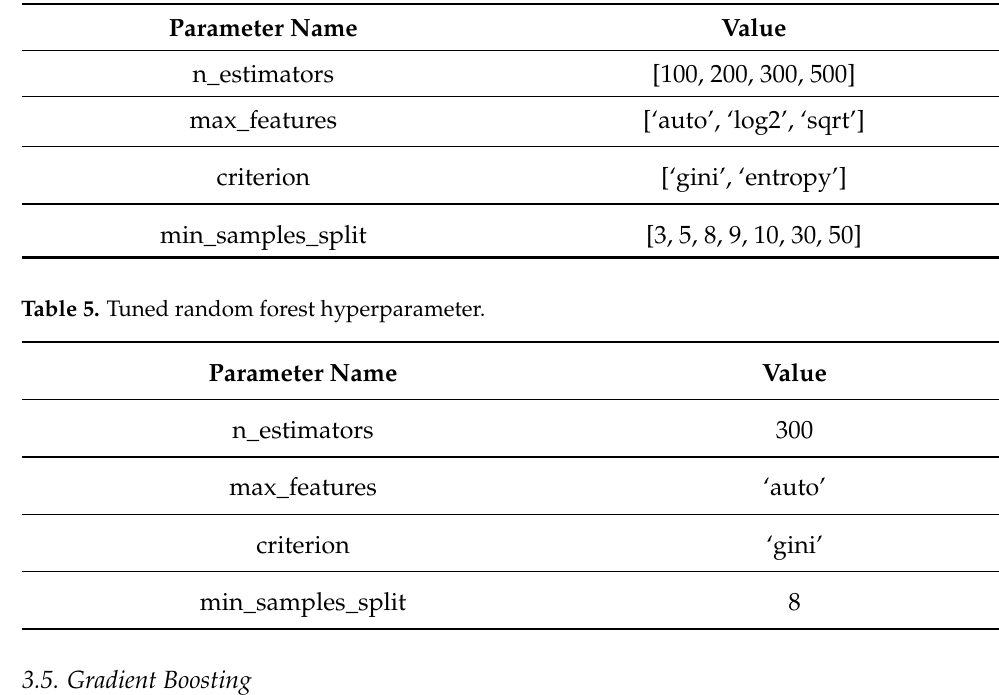
Table 4. Random forest hyperparameter.